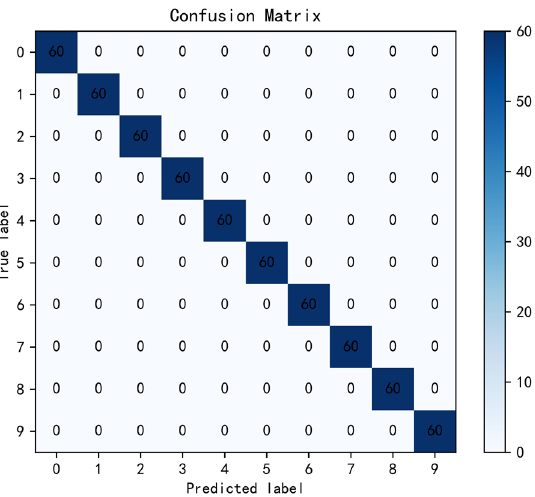
Figure 14. Experiment 2 confusion matrix results.